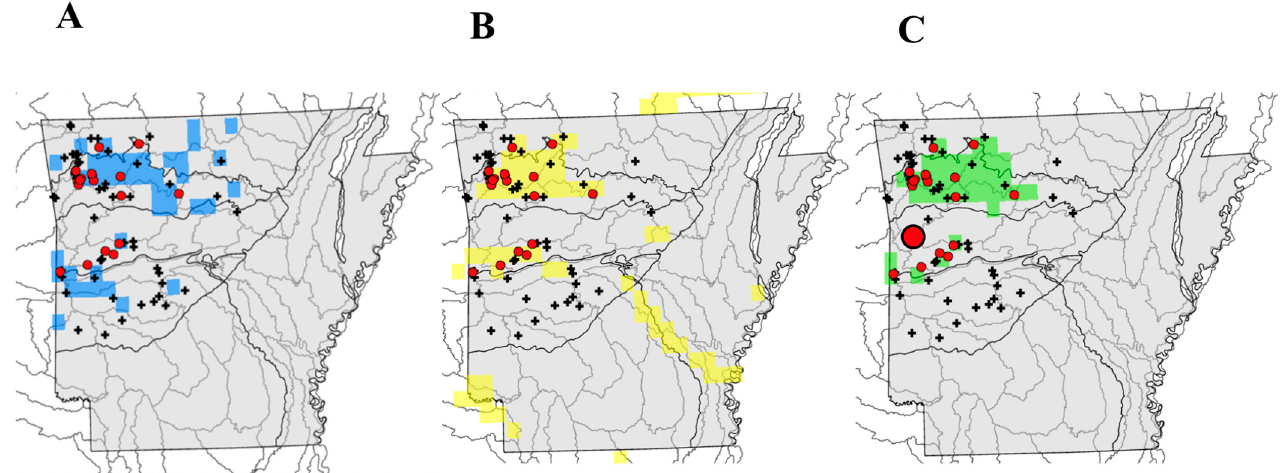
Figure 3. The Random Forest distribution models for Allocapnia mohri plotted with the known species distribution. A. mohri presence (red circle) and absence ( + ) sites are marked. The areas that the Landscape distribution model predicted would have A. mohri presence are marked in blue ( A ). The areas that the Climate distribution model predicted would have A. mohri presence are marked in yellow ( B ). The combined Landscape and Climate model prediction is in green ( C ). Table 3. Random Forest model scores for Out-of-Bag (OOB), F1, Mean Squared Error (MSE), Mat- thews Correlation Coefficient (MCC), Accuracy, and Validation Accuracy variables used in Multiple Logistic Regression analyses grouped by hypothesis.